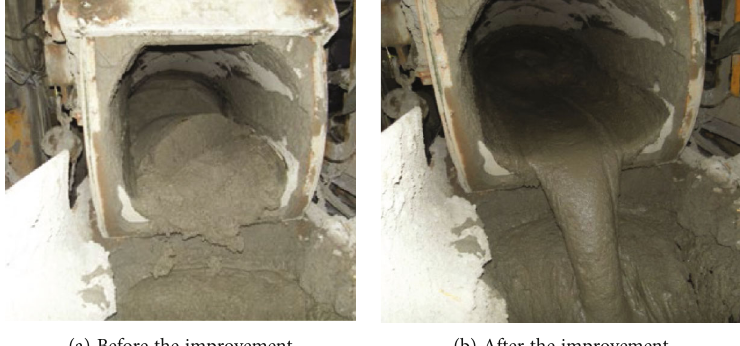
Figure 7: The improvement e ff ect of the ballast soil.